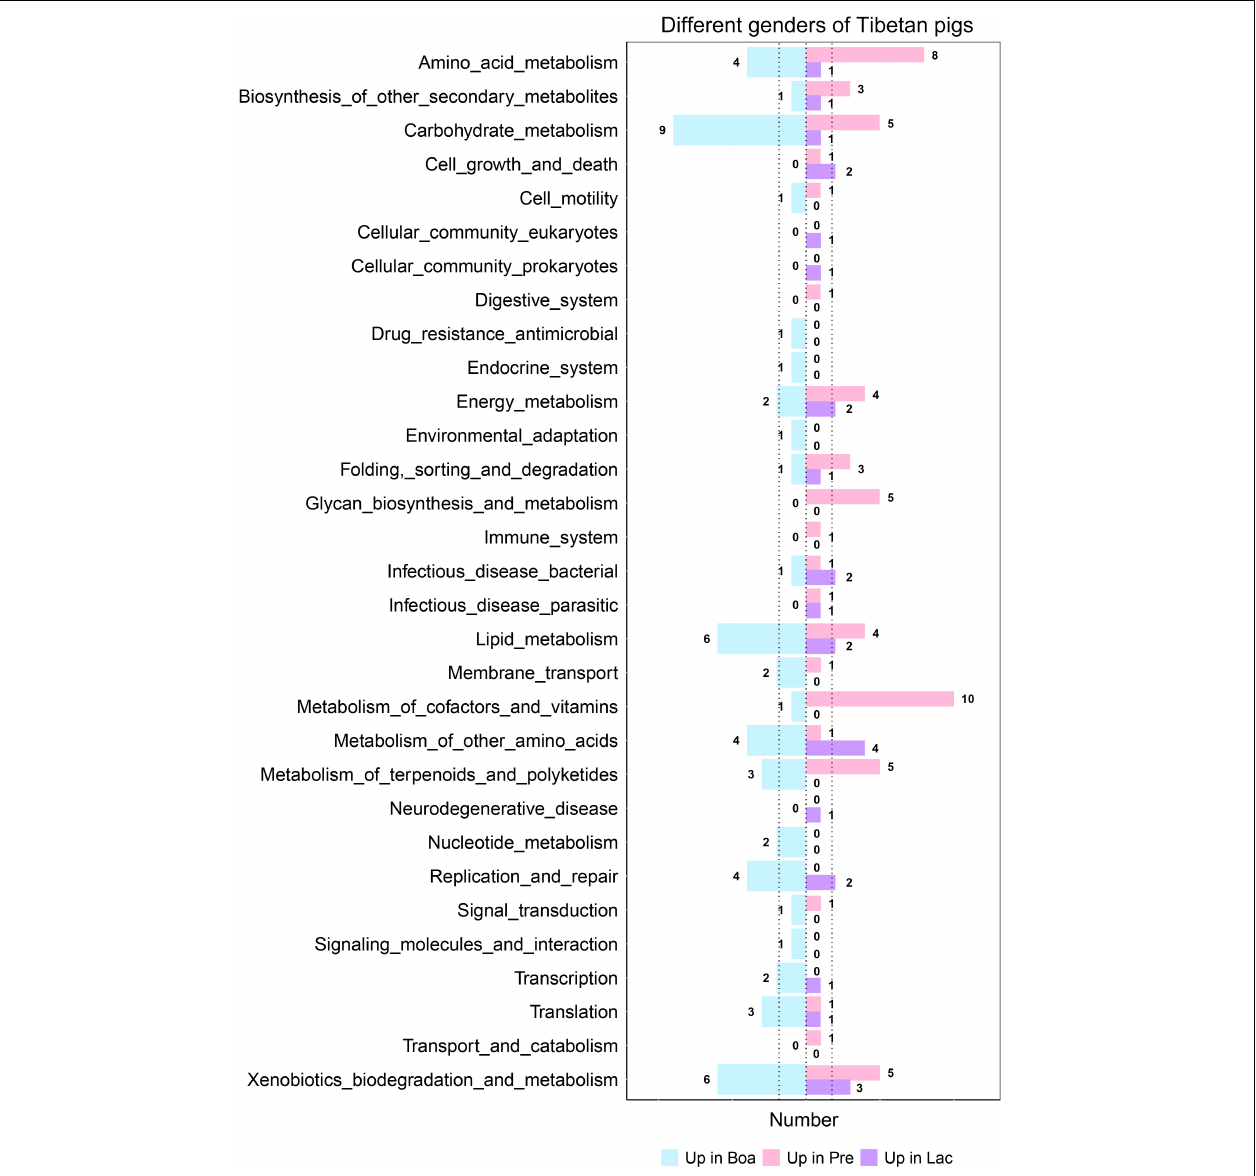
Frontiers in Microbiology |